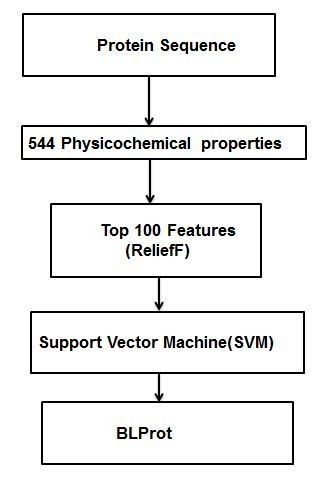
Workflow of BLProt.